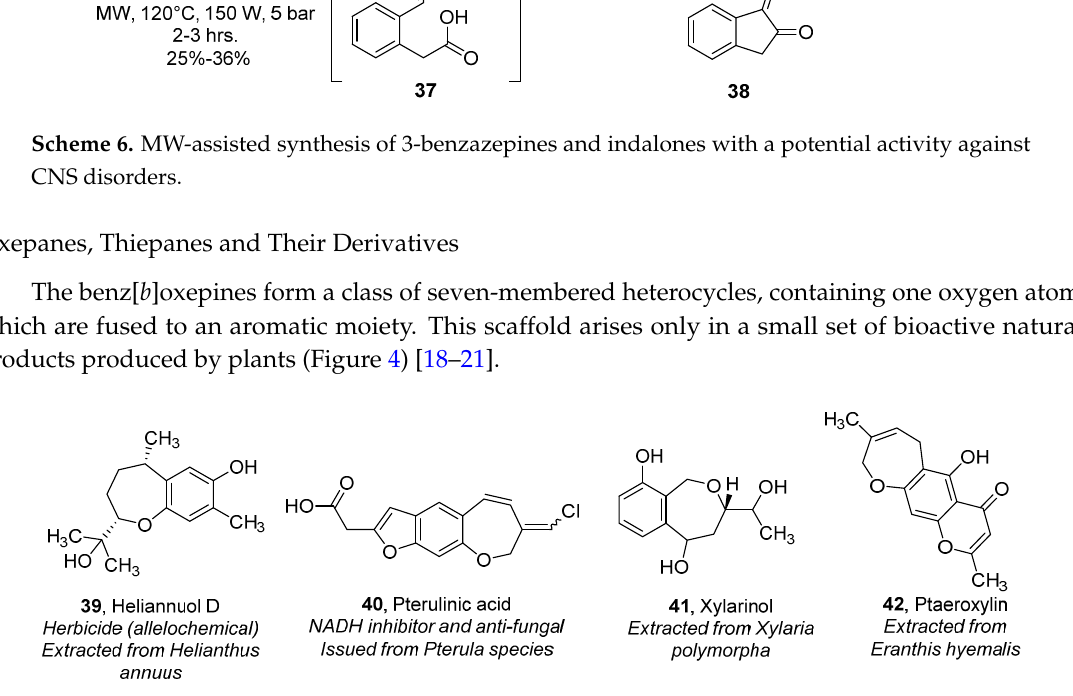
Figure 4. Relevant examples of bioactive benz[ b ]oxepines.